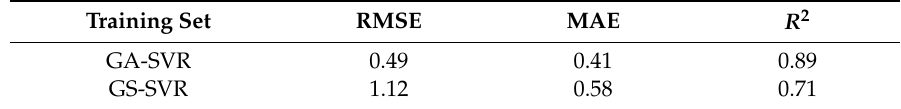
Figure 4. Genetic algorithm optimized support vector regression (GA-SVR) flowchart involved in prospectivity modeling for the Axi epithermal gold deposit. Table 1. Performance comparison of GA-SVR and grid search optimized support vector regression (GS-SVR).